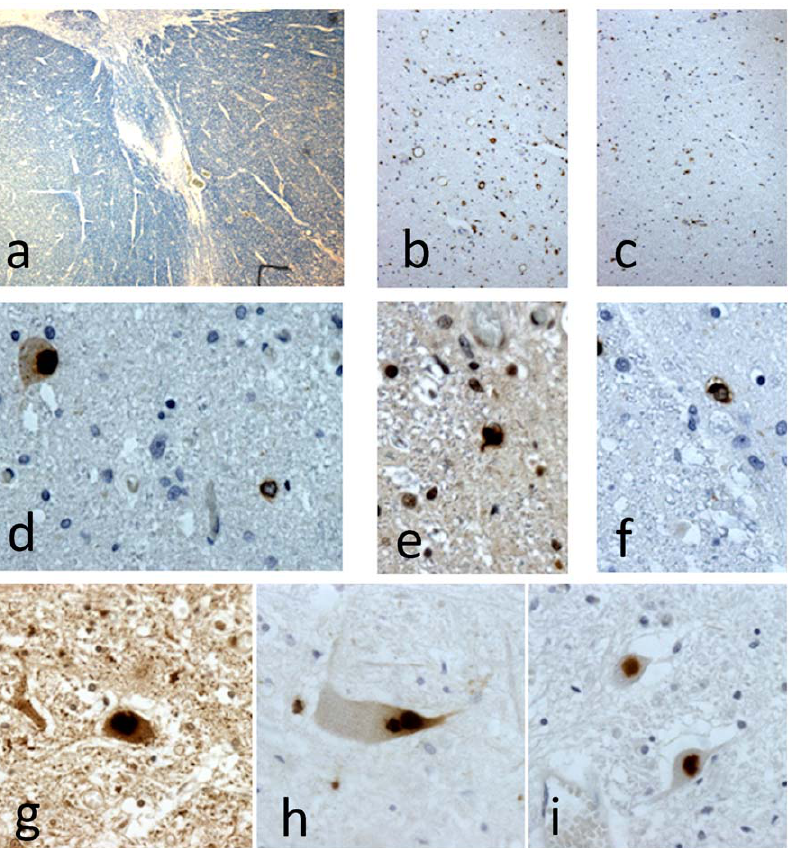
Figure 2. Photomicrography of pathological changes associated with CHMP2B mutations. In all cases there was no evidence of myelin pallor affecting the corticospinal tracts ( a ). Case 1 showed some minor upregulation of CD68 immunoreactivity in the spinal lateral corticospinal tracts ( b ) compared with the dorsal columns ( c ). Sequestosome 1/p62 staining showed compact intraneuronal inclusions in spinal motor neurons and occasional glial inclusions ( d ). The glial inclusions show coiled body morphology immunoreactive for both TDP43 ( e ) and p62 ( f ). All cases showed a predominance of compact intraneuronal inclusions in motor neurons ( g–i ). (a: Luxol fast blue; b,c: CD68; d,f,h,i: p62; e,g: TDP43. Microscopy at 6 2 obj. (a); 6 10 obj. (b,c); 6 40 obj.